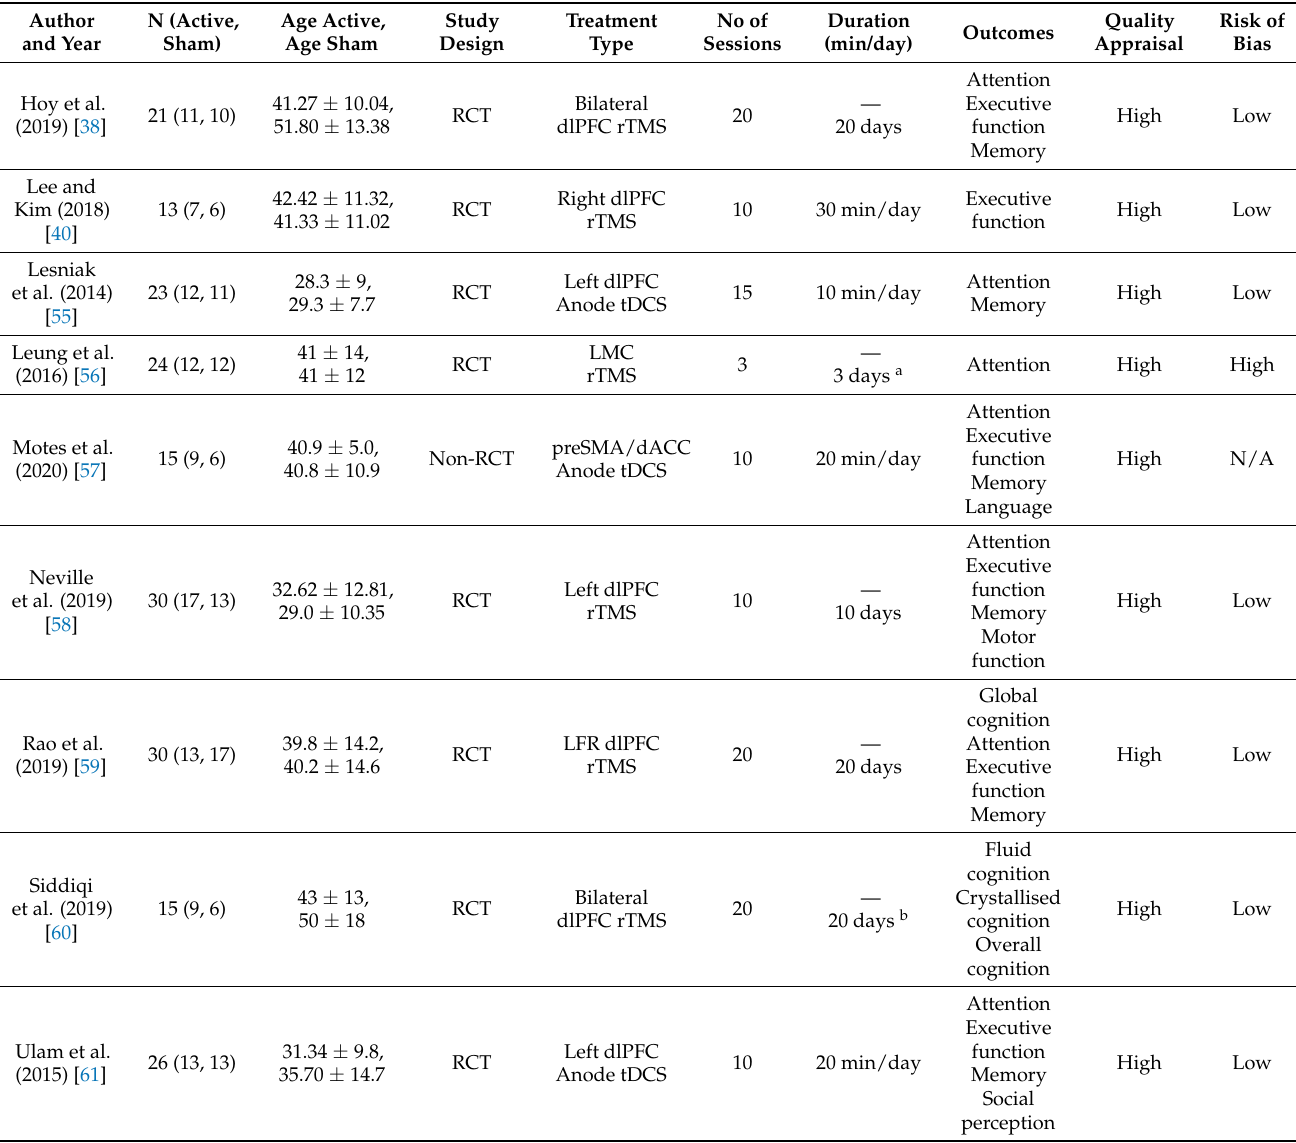
Table 1. Characteristics of the included